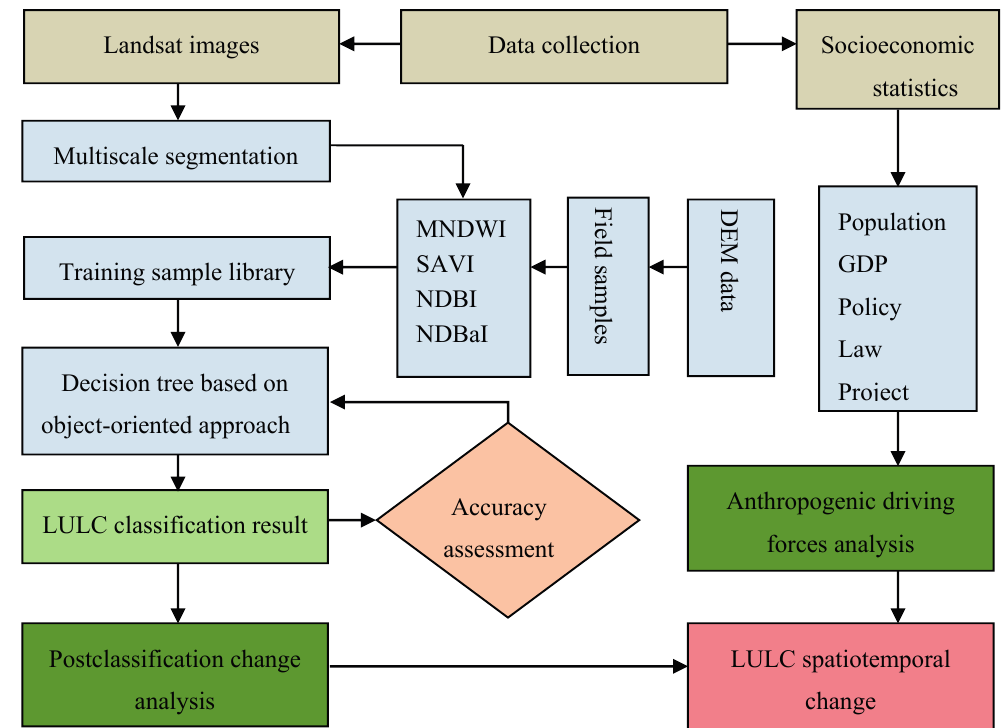
Figure 2. Flow chart of the